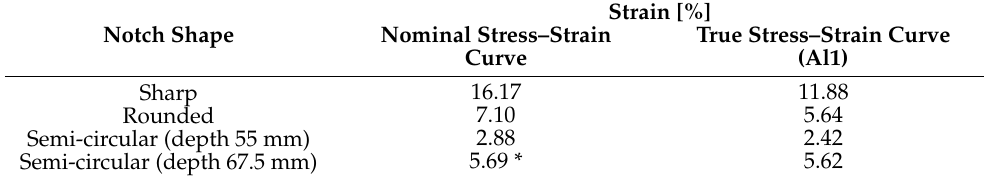
Figure 23. Von Mises stress–strain curves for the ( a ) nominal and ( b ) true stress–strain curves. Table 6. Numerical modelling—strain at 5.0 kN.